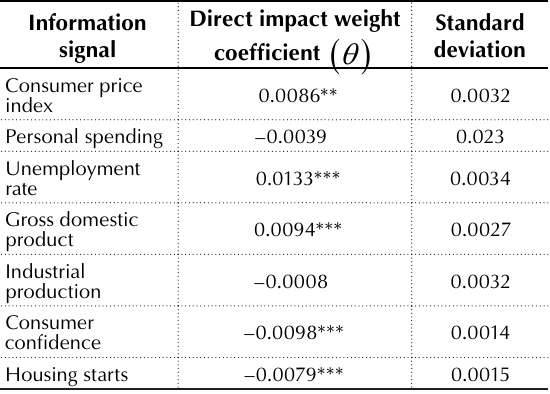
Table 1. The influence of the component of “surprise” on non-monetary information signals of the USA on the volatility of the PFTS stock index Source: Compiled and calculated by the